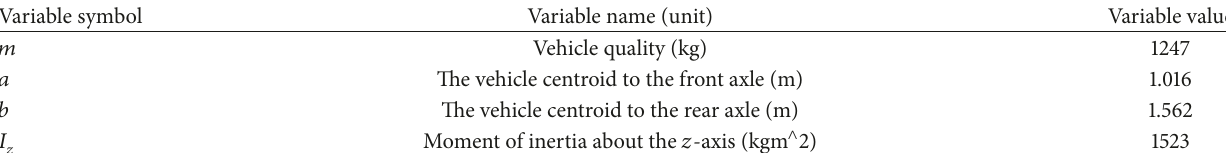
Table 2: Parameters of vehicle settings in Carsim.